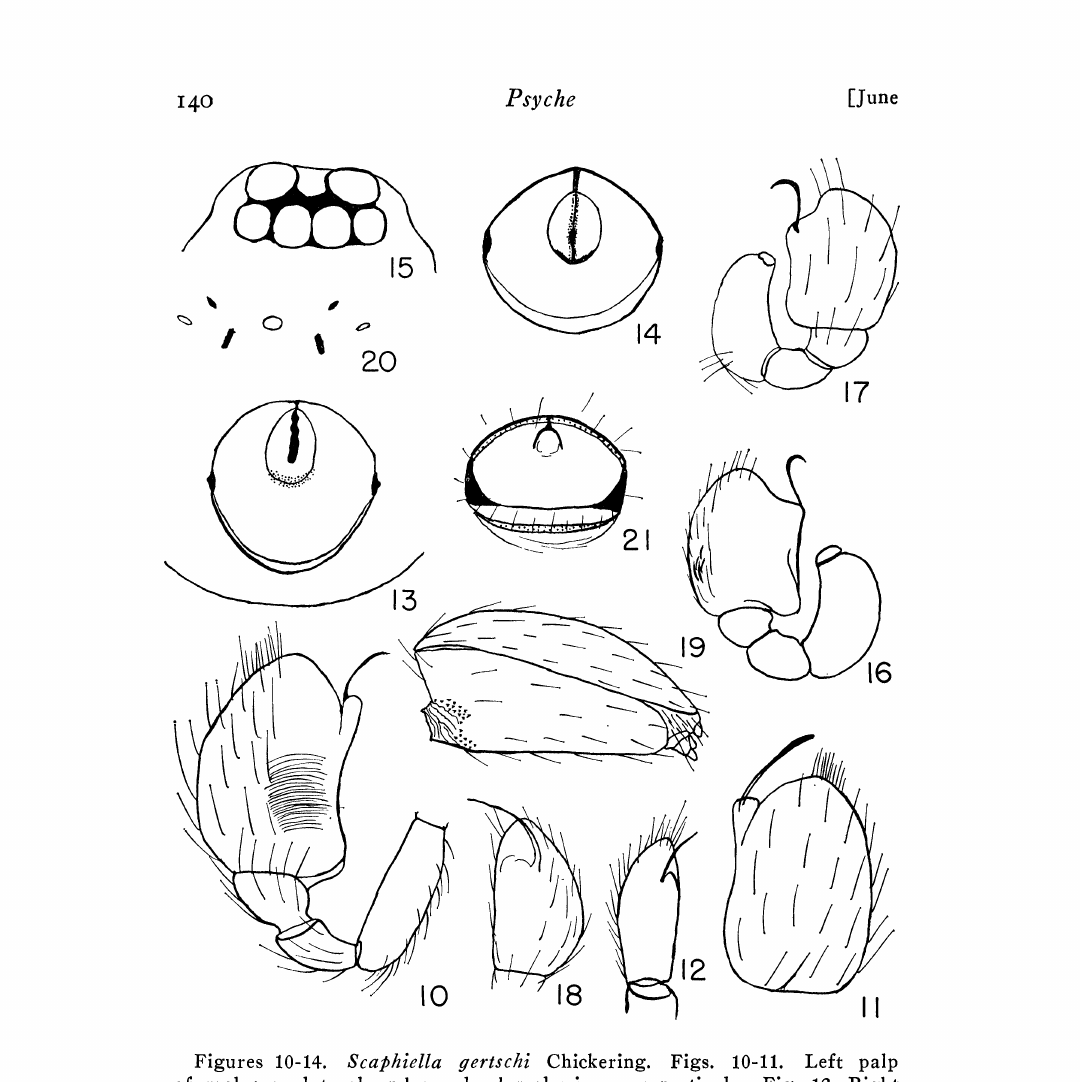
Figures 10-14. Scaphiella gertschi Chickering. Figs. 10-11. Left palp ot male; prolateral and nearly dorsal views, respectively. Fig. 12. Right palpal tarsus; nearly ventral view. Figs. 13-14. Epigynal areas; tw,o vari- ations in appearance of this region. Figures 15-21. Scaphiella kalunda sp. nov. Fig. 15. Eyes of male from above. Figs. 16-17. Left male palp; pro- lateral and retrolateral views, respectively. Fig. 18. Left male palpal tarsus; nearly ventral view. Fig. 19. Male abdomen; lateral view; left side. Fig. 20. Genital area of male from below. Fig. 21. Epigynal area from